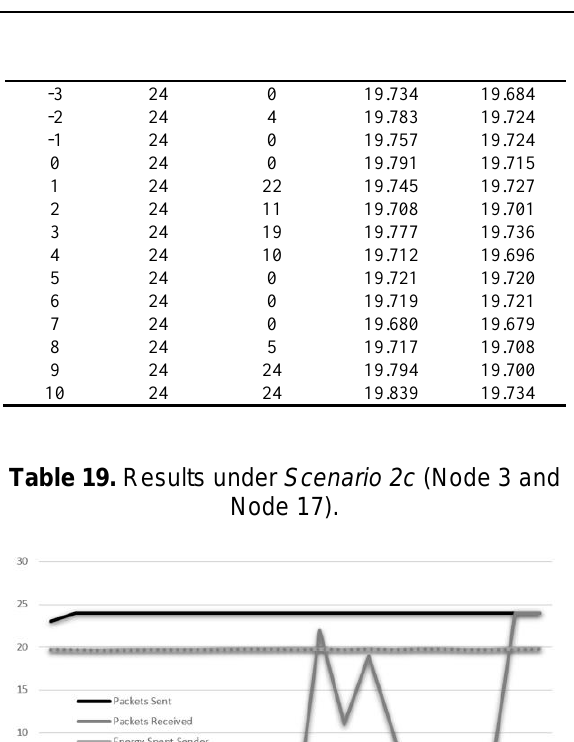
Figure 14. Remaining Energy vs Transmission